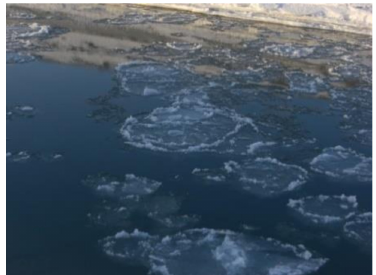
Figure 11. Photo of the surface ice in the